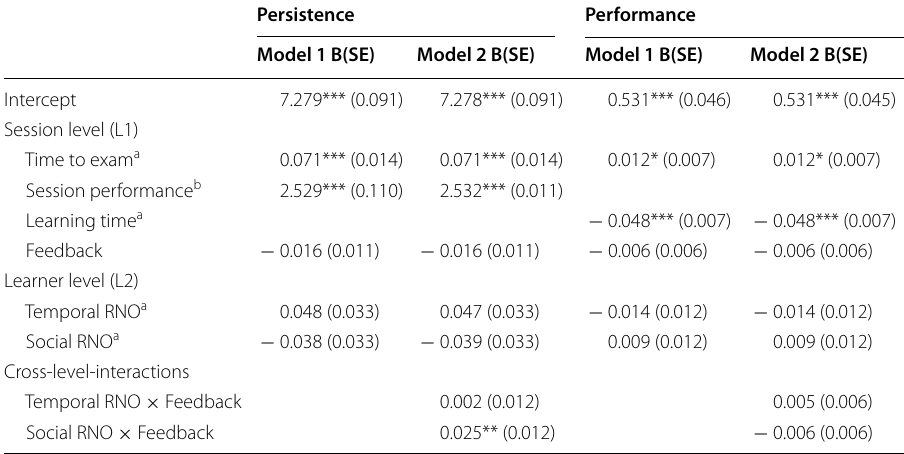
N 4108. RNO reference norm orientation (preferences for comparison standards). Persistence measured as learning time = = per session (L1, logarithmized), performance as mean performance on items presented with feedback (L1, logarithmized). Effect coding of feedback type ( 1 temporal, 1: social). a standardized variables, b session performance entered as p − to investigate higher persistence under medium difficultly exercises *p < 0.1, **p < 0.05, ***p <